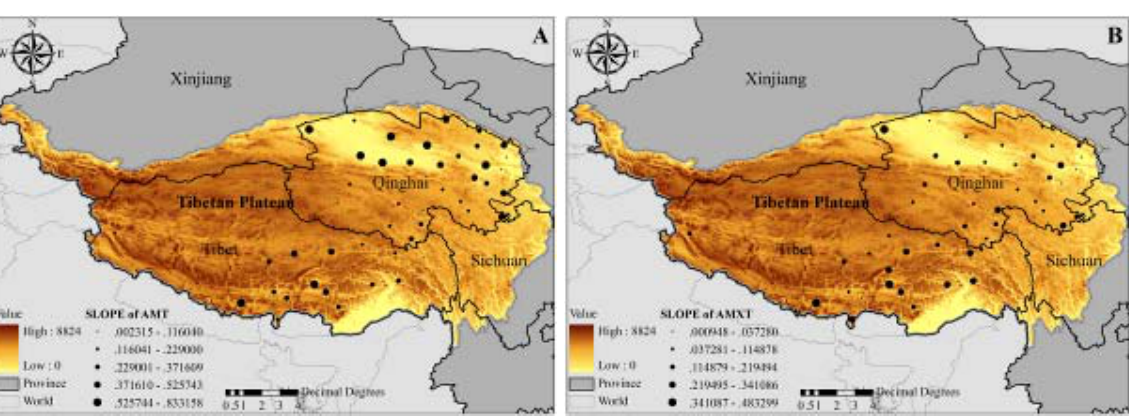
Figure 2. Annual trend slopes of ( A ) AMT, ( B ) AMXT, ( C ) AMNT, ( D ) AMTS, ( E ) AAT, ( F ) AMP, ( G ) AMXP, and ( H ) AMPS from 1960 to 2002. Black solid circles represent the slopes of all observatory